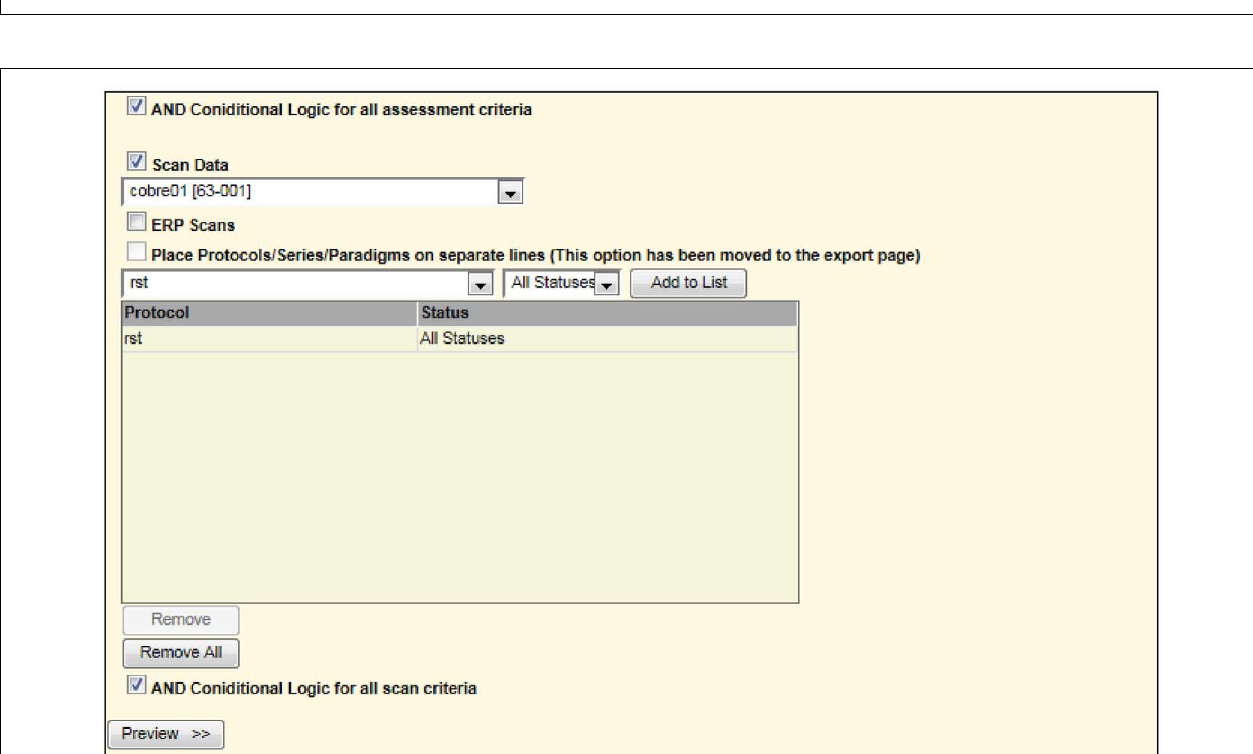
FIGURE 6 | Upper portion of query builder specifying the handedness field for a specific study.